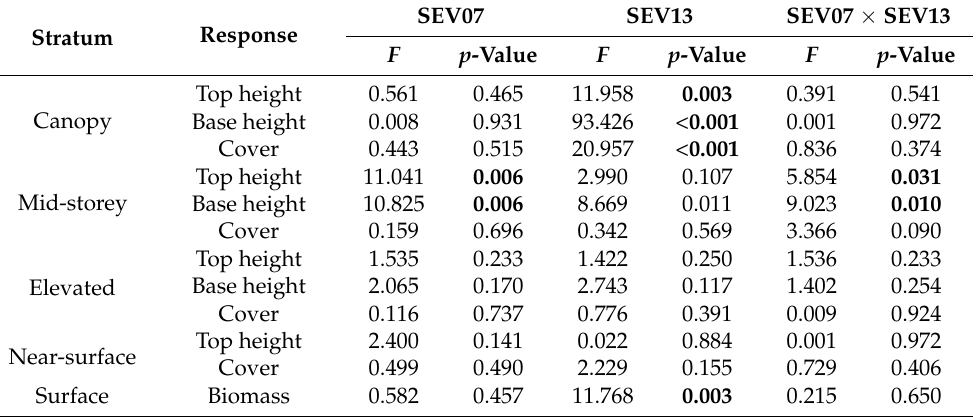
Table 1. Summary of the models that were used for testing the effects of fire severity combinations on fuel properties. Five fuel strata were considered. The effect of the fire severity combinations on crown top height, base height and cover were assessed for each vegetation stratum (excluding the base height for near-surface fuels). Fuel biomass was assessed for surface fuels. Values highlighted in bold are statistically significant ( p < 0.05). SEV07 SEV13 SEV07 × SEV13 Stratum Response p -Value p -Value Top Canopy